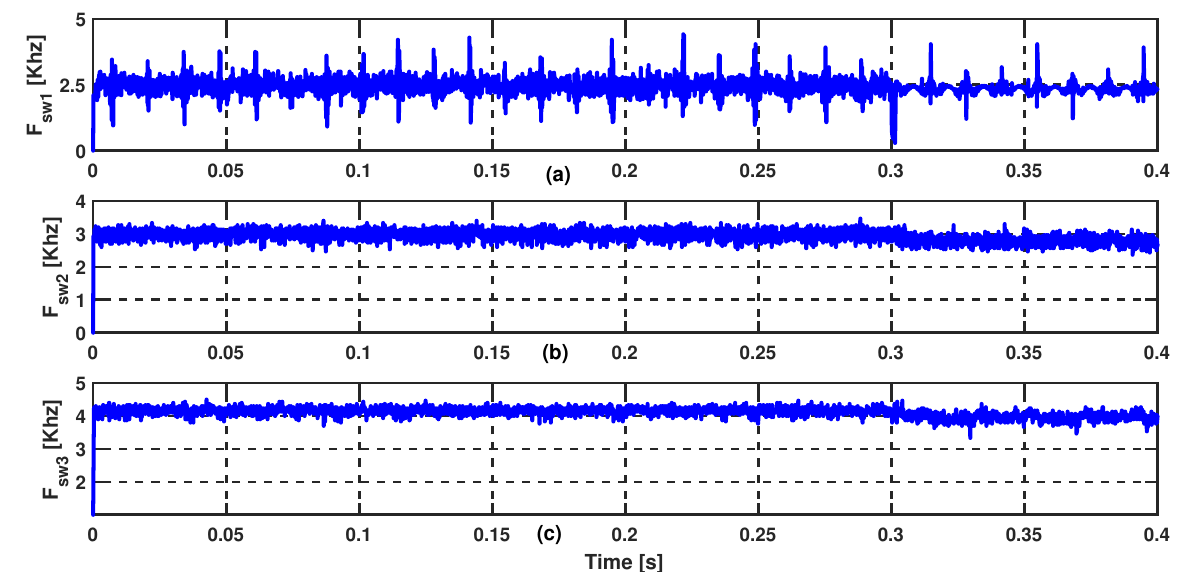
Figure 16. Switching frequency for the three methods (from top): Conventional FCS-MPC, 2VV FCS-MPC, and 3VV